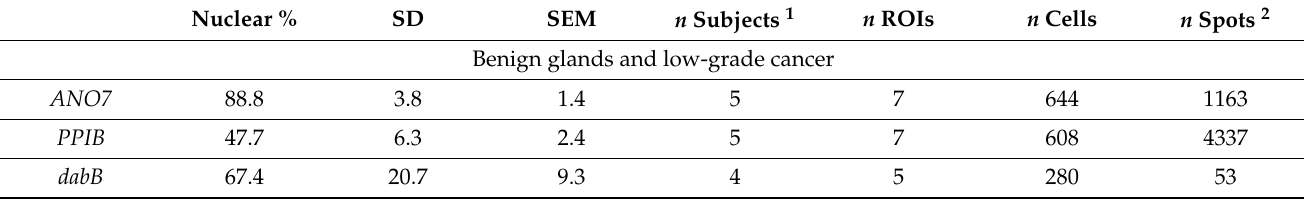
Table 1. Nuclear enrichment of transcripts in prostate